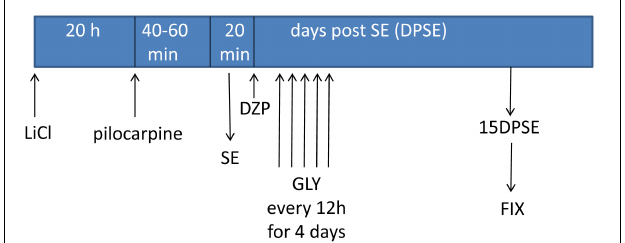
FIGURE 6 | Schematic representation of the in vivo treatment with HMGB-1 antagonist glycyrrhizin after pilocarpine-induced status epilepticus (SE).